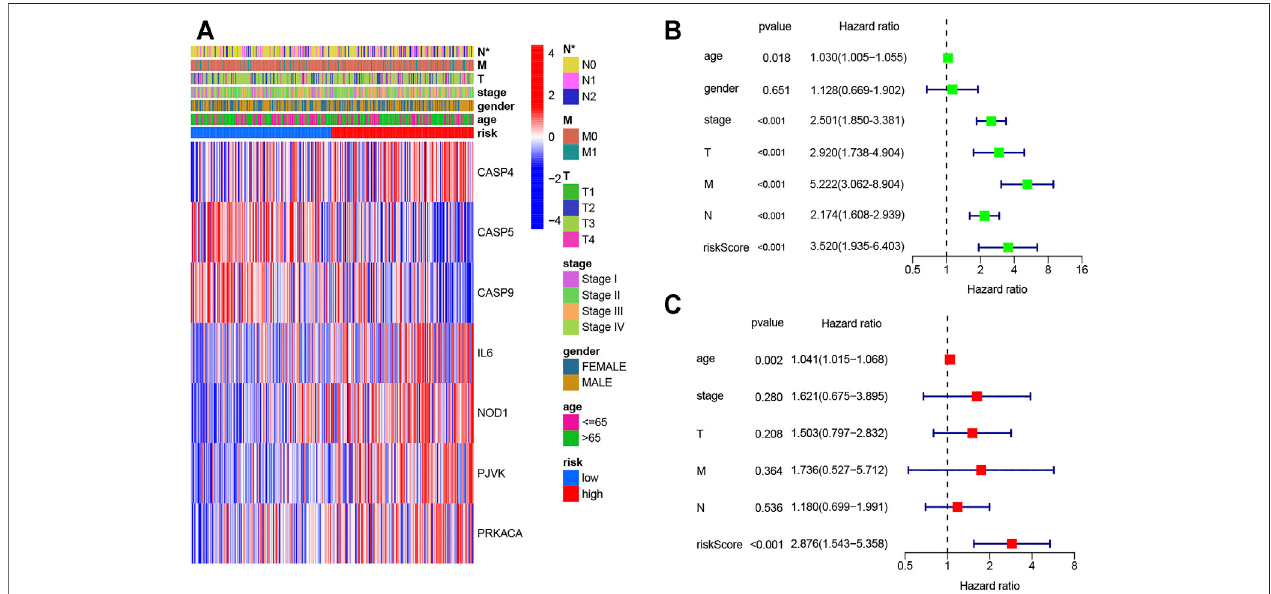
FIGURE 5 | Univariate and multivariate Cox regression analyses for the risk score. (A) Heatmap (blue: low expression; red: high expression) for the connections between clinicopathological features and the risk groups (* p < 0.05); (B) univariable Cox regression analysis for the risk score; (C) multivariable Cox regression analysis for the risk